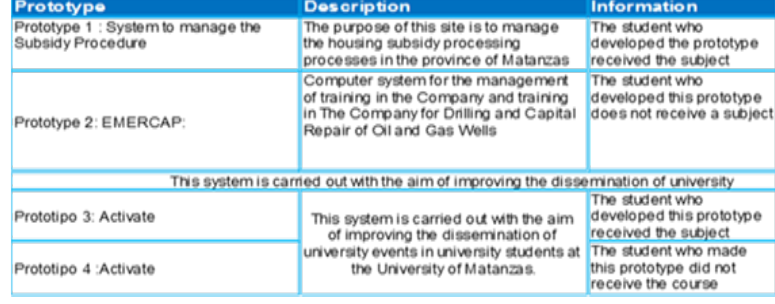
Fig. 3. Selected prototypes prior to the final